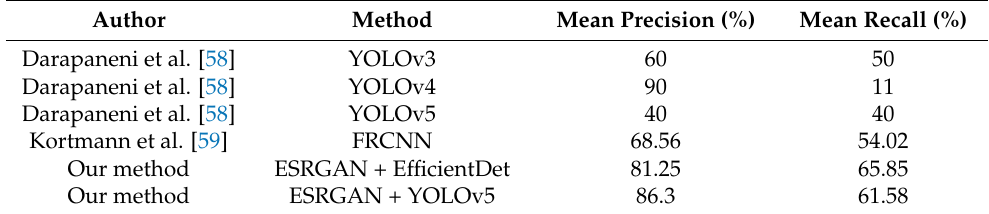
Table 5. Comparative evaluation of the proposed ESRGAN + YOLOv5 and ESRGAN + EfficientDet with Darapaneni et al. [58] and Kortmann et al. [59] on the Japan